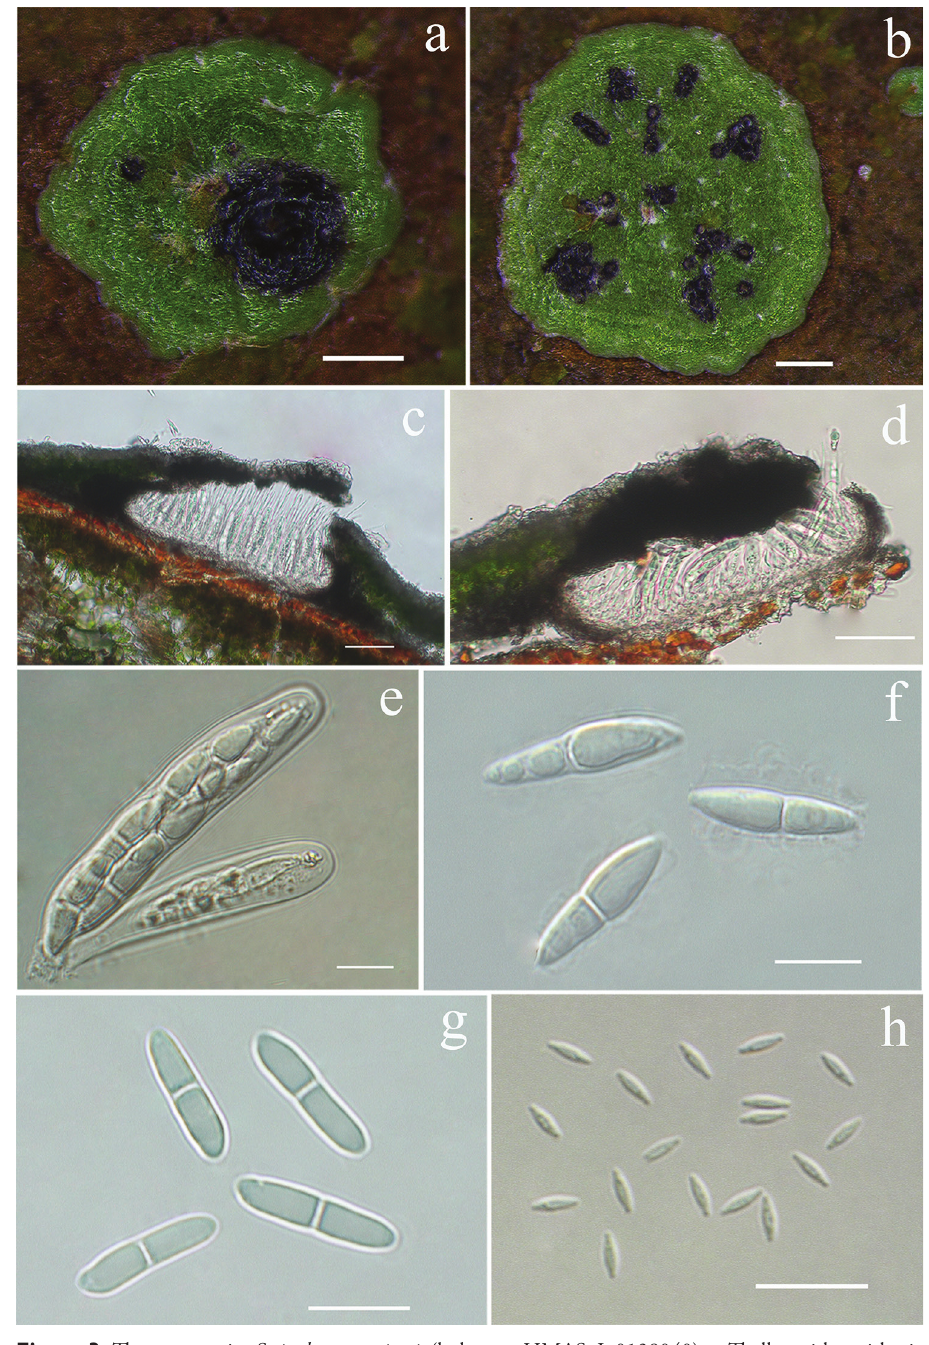
Figure 3. The new species Strigula guangxiensis (holotype, HMAS–L 0138040) . a Thallus with perithecia b Thallus with pycnidia c, d Perithecia e Asci with eight biseriate ascospores f Ascospores, with distal cell slightly enlarged g Macroconidia; h Microconidia. Scale bars: a, b =100 µm; c, d =50 µm; e, f, g, h =10